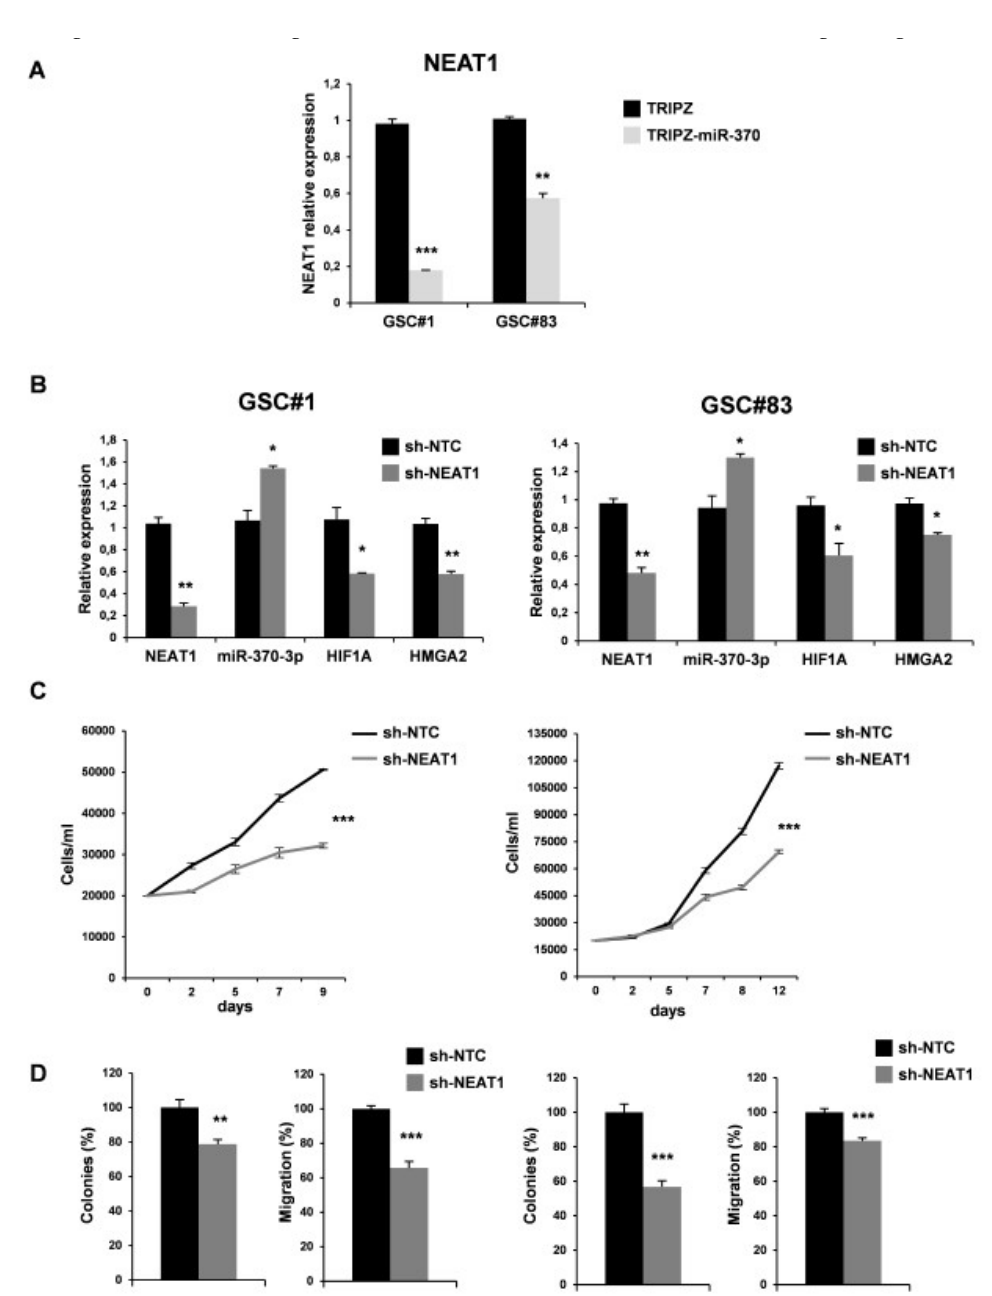
Figure 6. NEAT1 knockdown impairs GSC tumorigenicity. ( A ) Real time PCR analysis for NEAT1 on GSC#1 and GSC#83 miR-370-3p transduced lines confirmed the down-regulation of the lncRNA. ** p < 0.01; *** p < 0.001. ( B ) Real time PCR for NEAT1, miR-370-3p, HIF1A and HMGA2 on GSC#1 (left panel) and GSC#83 (right panel) transduced with short hairpin (sh)NEAT1 or its no target control lentiviral vector (shNTC). * p < 0.05; ** p < 0.01. ( C ) Growth curves, ( D ) analysis of e ffi ciency in colony formation and analysis of migration e ffi ciency in GSC#1 (left panel) and GSC#83 (right panel) transduced with shNEAT1 or shNTC. Values shown are mean ± SD from two independent experiments in triplicate. ** p < 0.01; *** p <